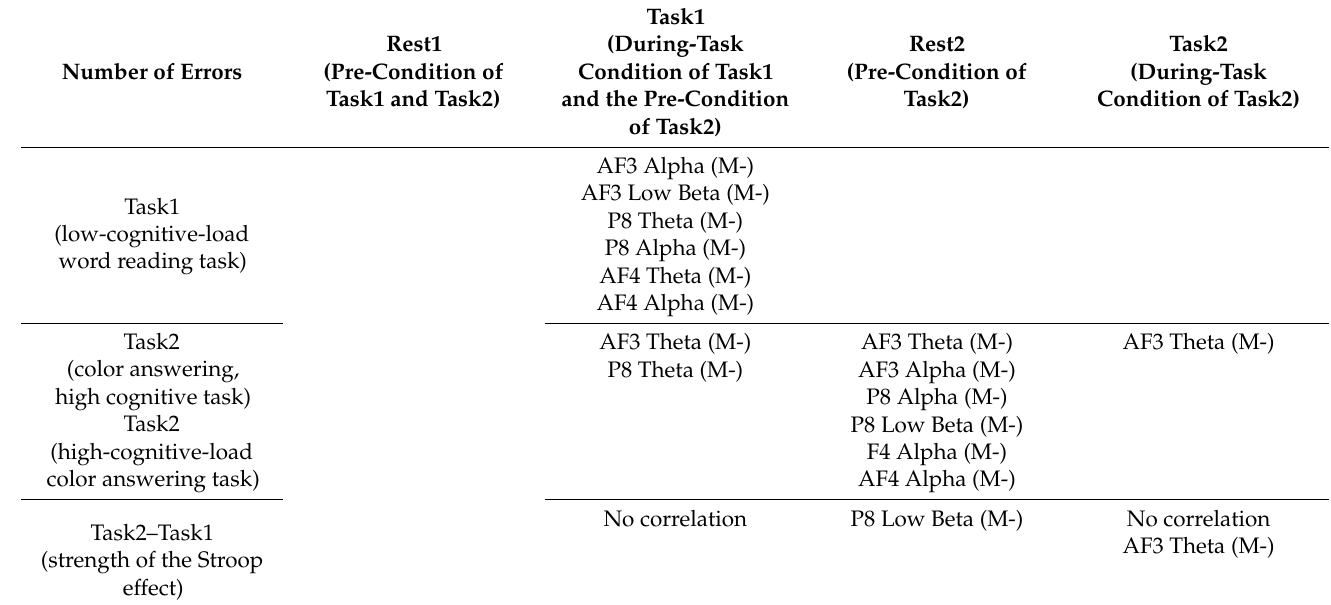
Table 17. Correlation analysis results of EEG indexes (“M-”: moderate negative